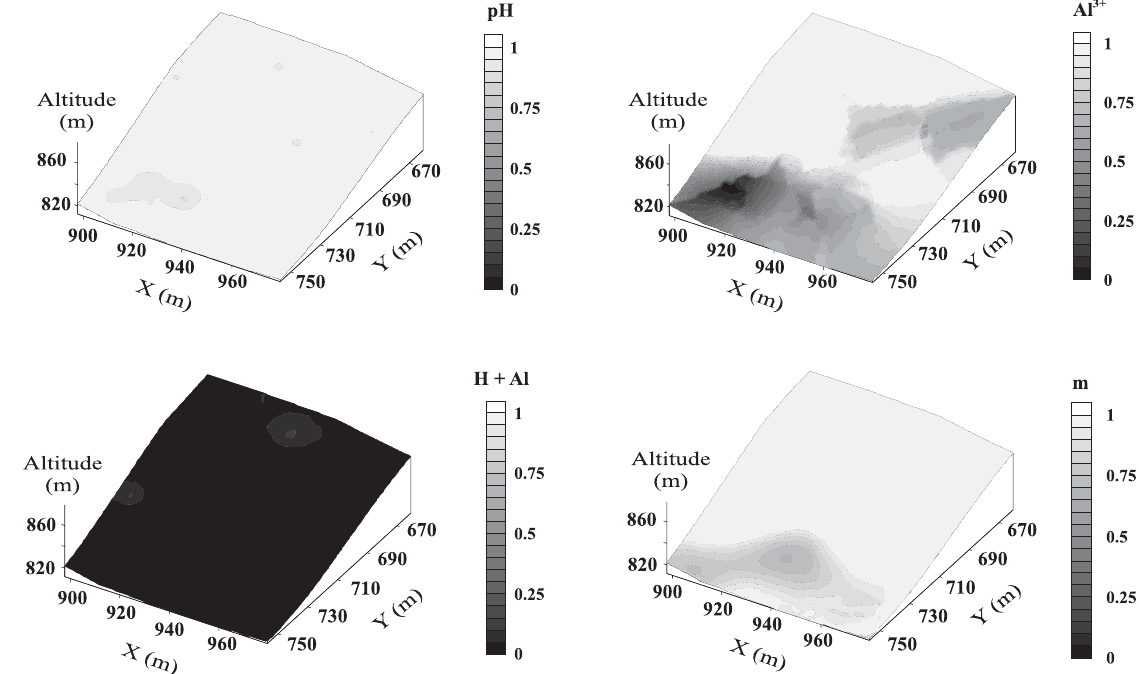
Figura 5. Mapas de classificação fuzzy para os atributos pH, Al 3+ , H + Al e